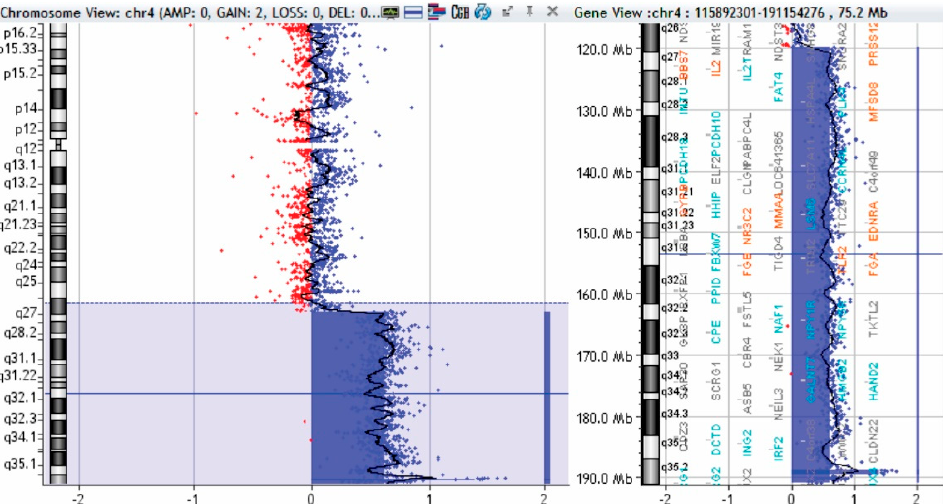
Figure 4. Array-CGH test of patient—triplication of 71,057 kb in the 4q26-q35.2 region (shaded in blue). Red and blue dots represent the log2 ratio of fluorescence (Cy5/Cy3), calculated by analytical software; log2 ratio at 1 indicates a duplication of the DNA of the region (3 copies) in the test sample versus the control (in blue color), and a log2 ratio at -1 indicates a deletion of the DNA of that region in the test sample versus the control (red deviation).